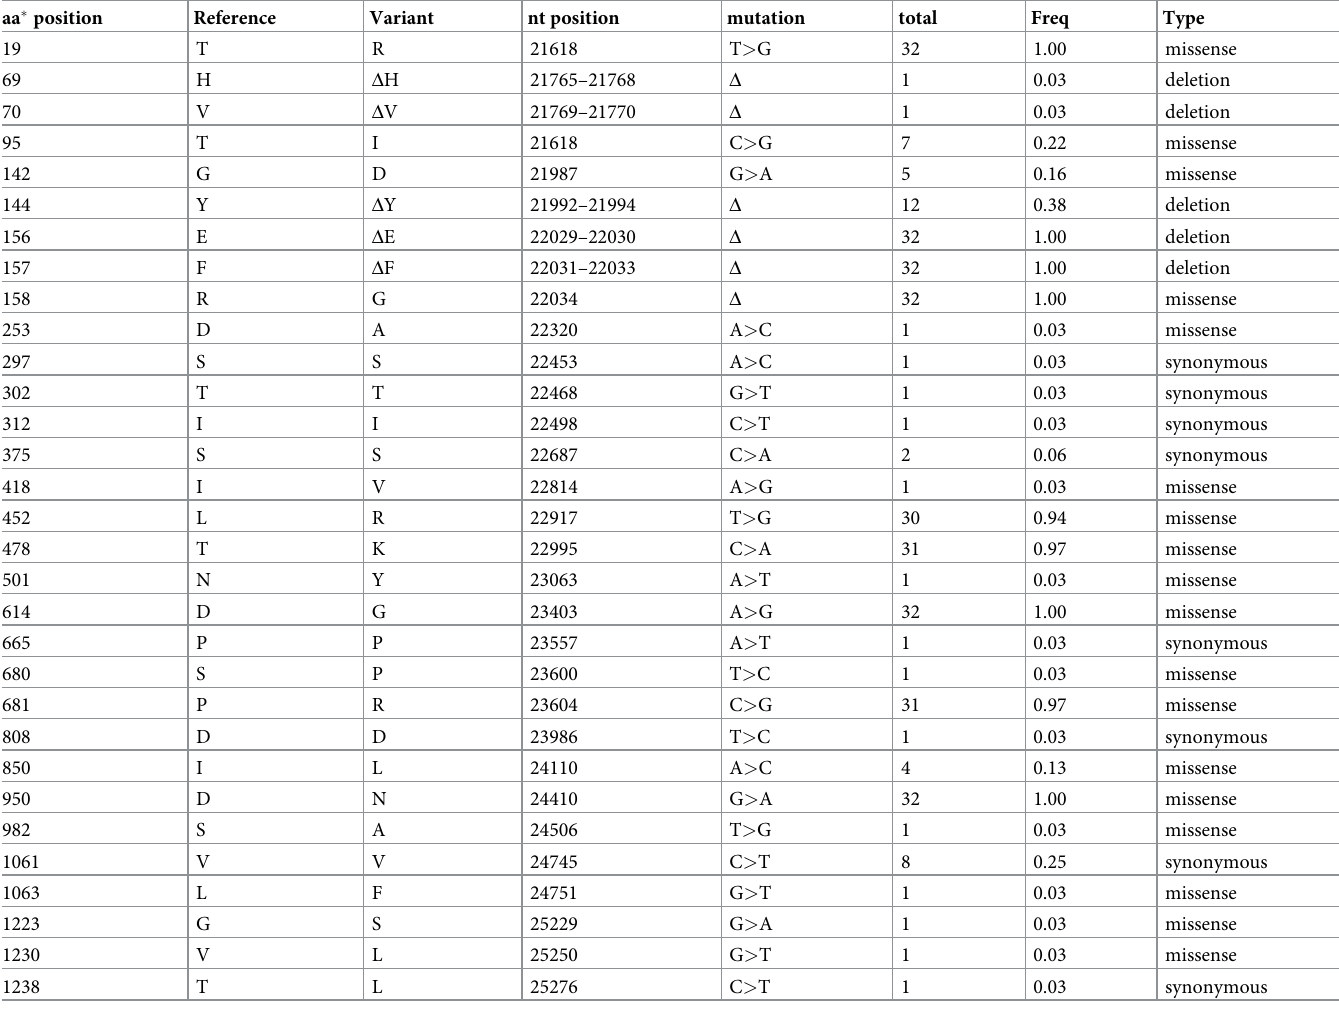
Table 6. Frequency of the identified Spike protein mutations (missense/synonymous) and deletions in the Delta isolates from Uzbekistan. aa �